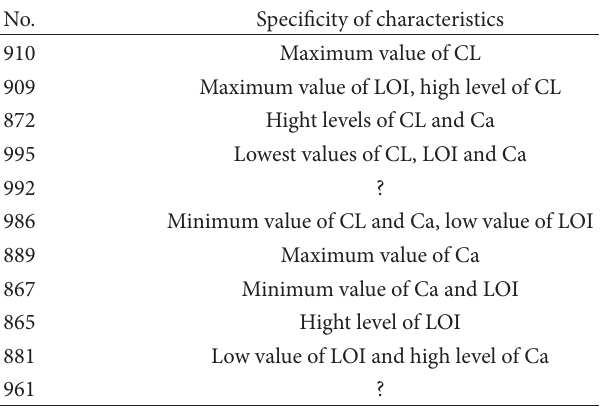
T 6: Speci�city of characteristics of samples for which high leverage and possibly in�uential measurements were